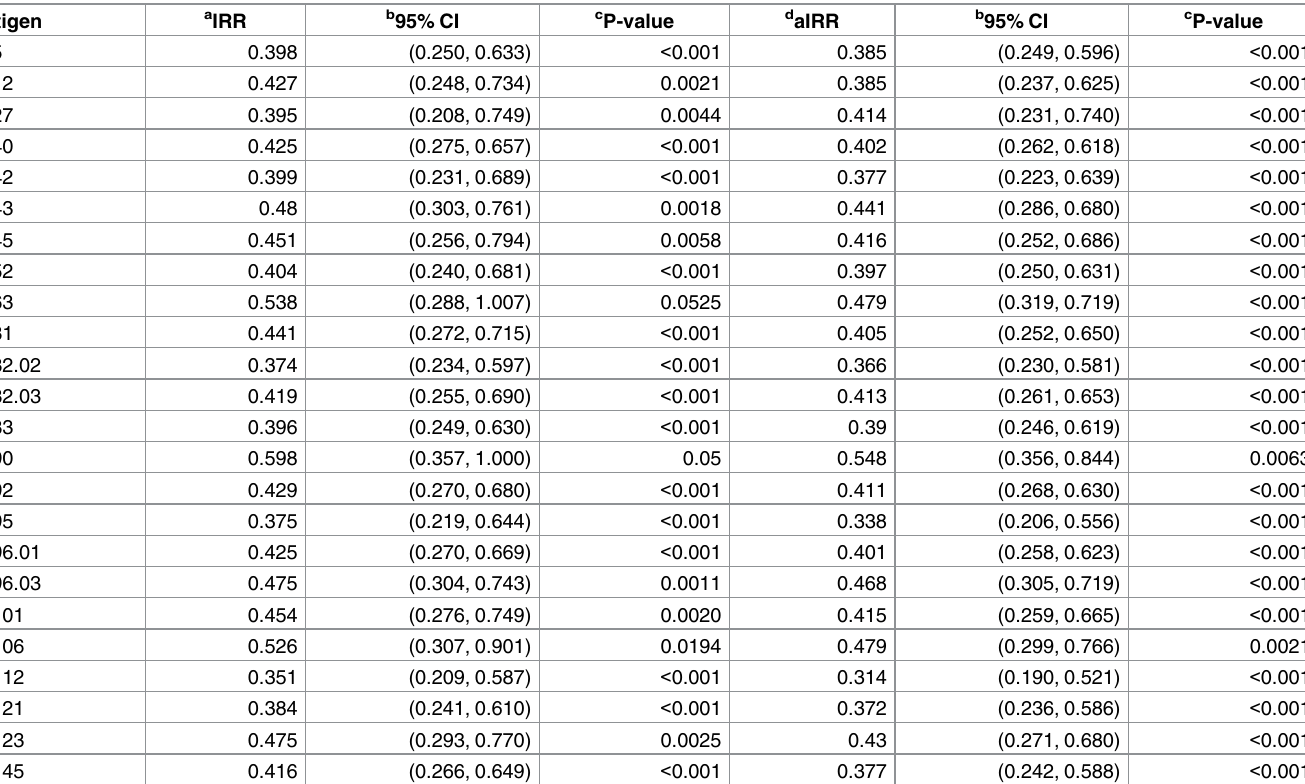
Table 4. Association between IgG levels to P . vivax antigens and protection against clinical malaria (parasite density > 500/ μ lof